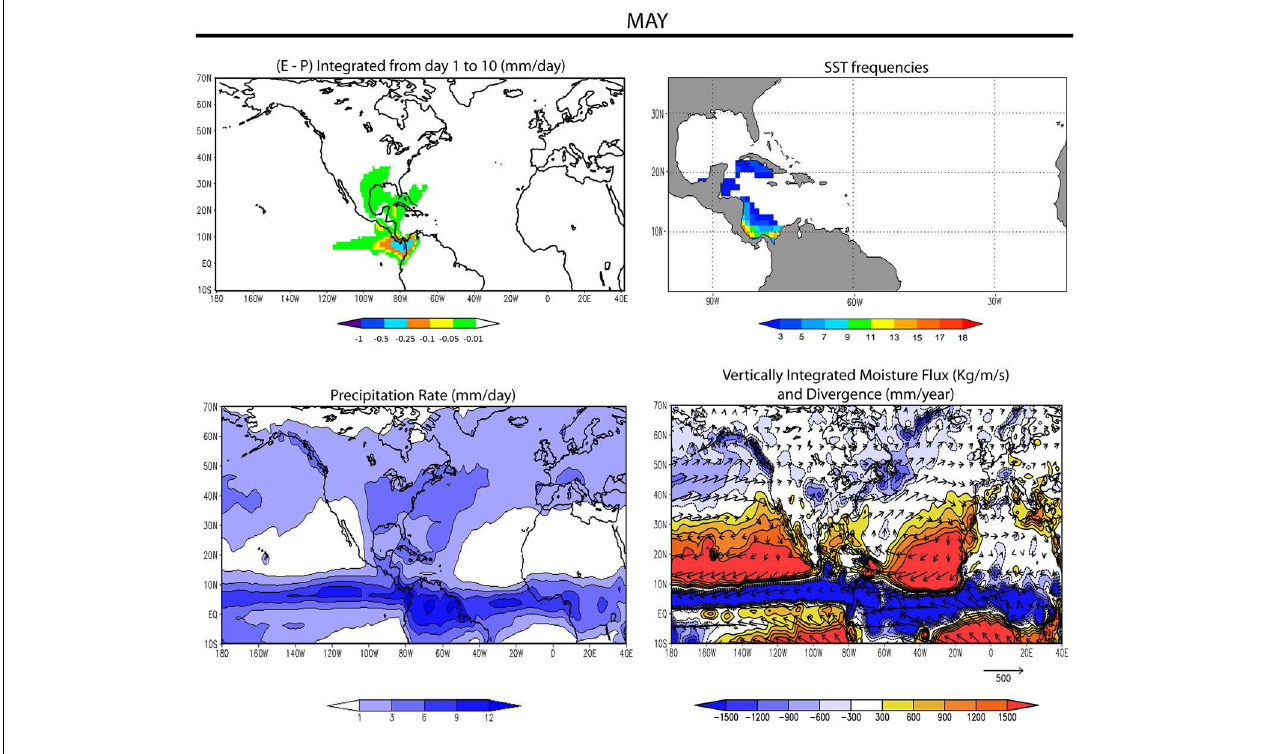
Precipitation rate. Bottom left : Vertically integrated moisture flux (VIMF) and its divergence. Units of ( E − P ) and precipitation rate are mm d − 1 , units of SST frequency are number of months, vectors of moisture flux are in kg m − 1 s − 1 , and units of contours of divergence of moisture are mm yr − 1